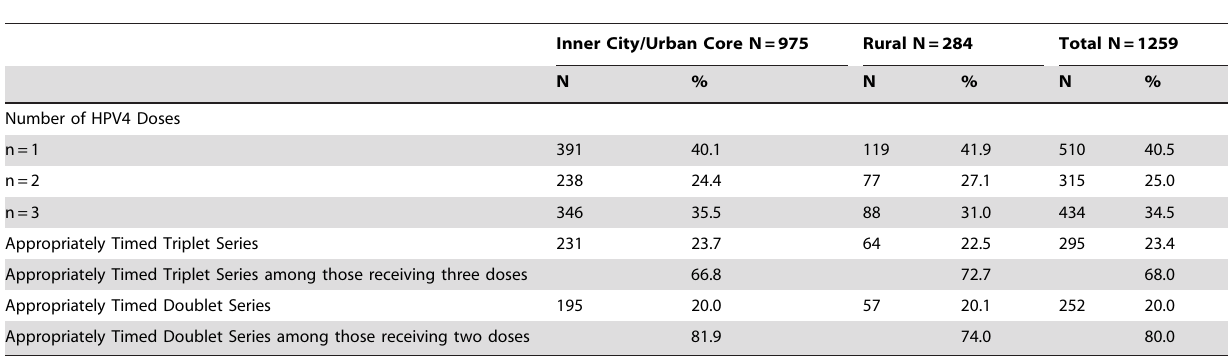
Table 2. Females receiving HPV4 by number of doses and Safety Net Health Center